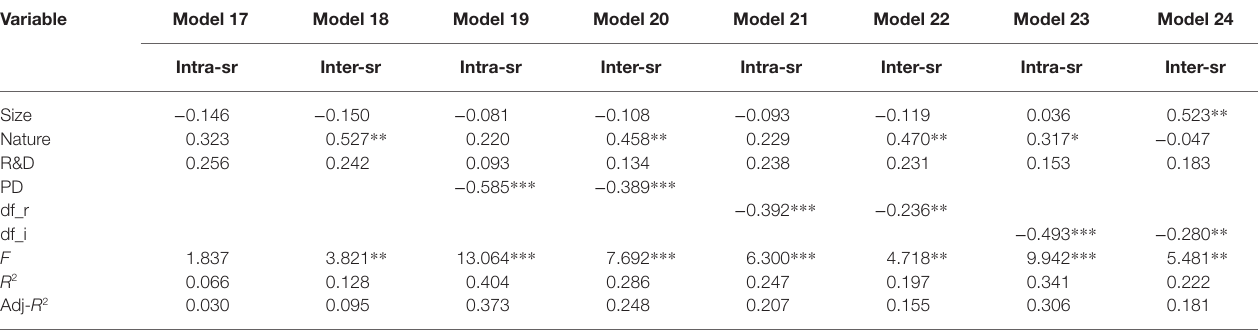
TABLE 6 | The direct relationship between psychological distance, divisive faultlines, and subgroup reciprocity in the technological innovation network (Group 1; N = 82).